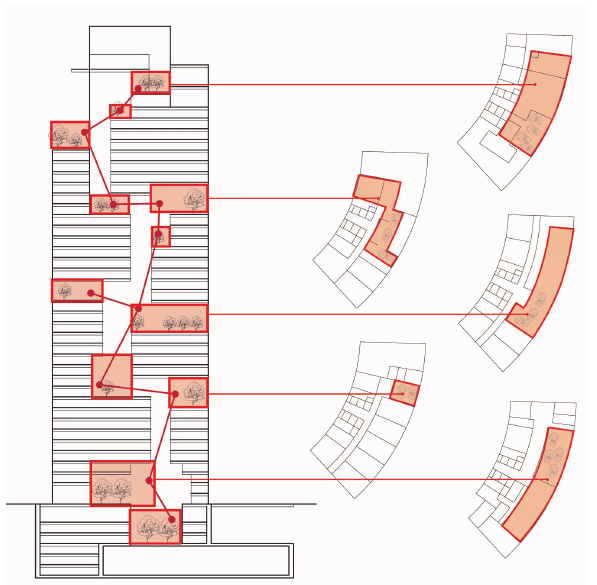
Fig. 1 Analysis of aerial courtyards connection in Sentafei Tower.